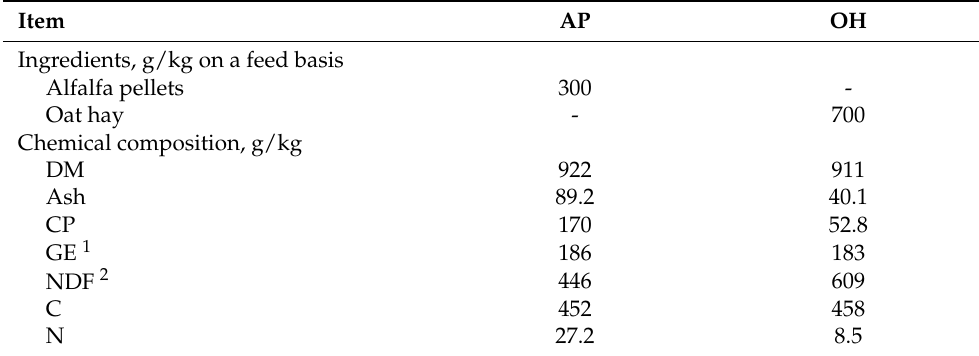
Table 1. Ingredients and chemical composition (g/kg DM) of dietary